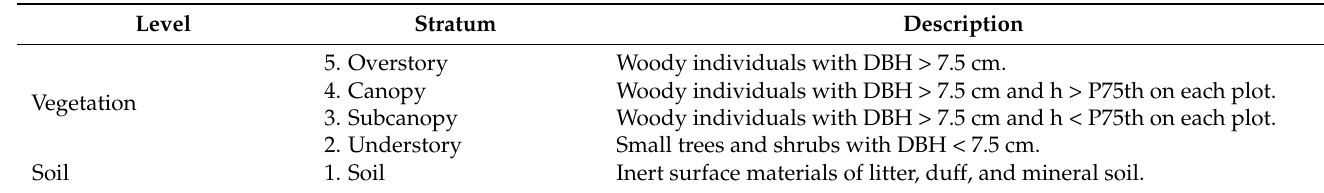
Table 2. Strata levels used in the field inventory performed in this study.